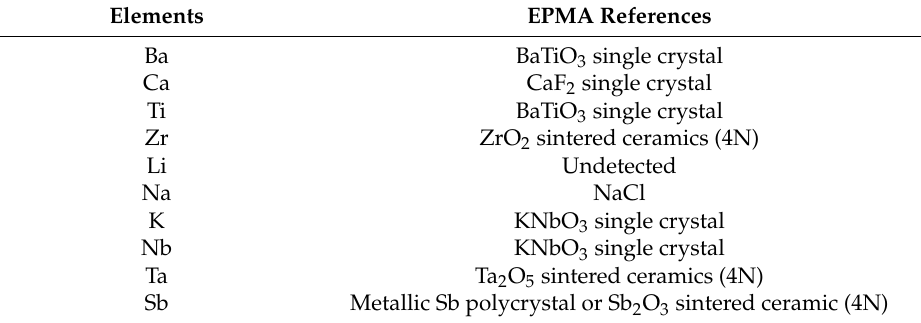
Table 1. Electron probe microscopy analysis (EPMA) reference samples for accurate quantitative analysis of